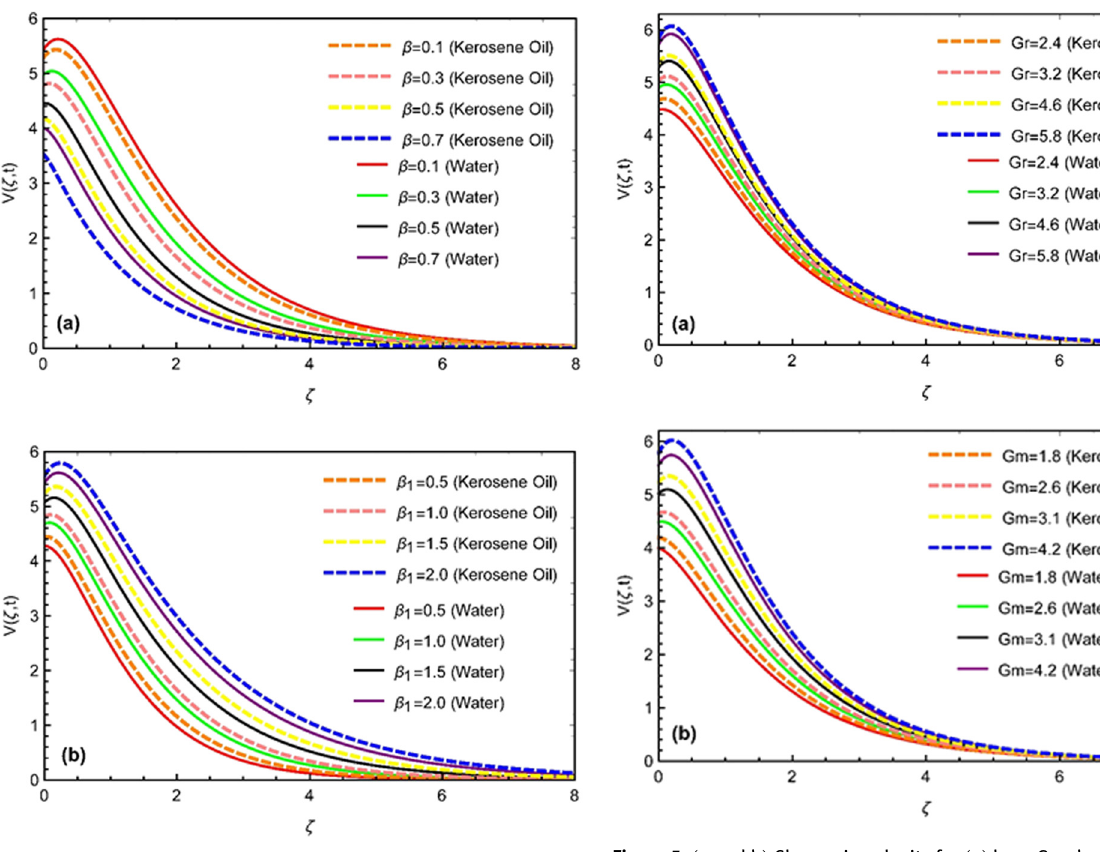
Figure 4: ( a and b ) Change in velocity for ( a ) fractional parameter β and ( b ) second - grade fl uid parameter β 1 for velocity fi eld with Pr = 5.6, Gr = 4.7, Gm = 4.2, Sc = 3.9. t = 1.3, φ =